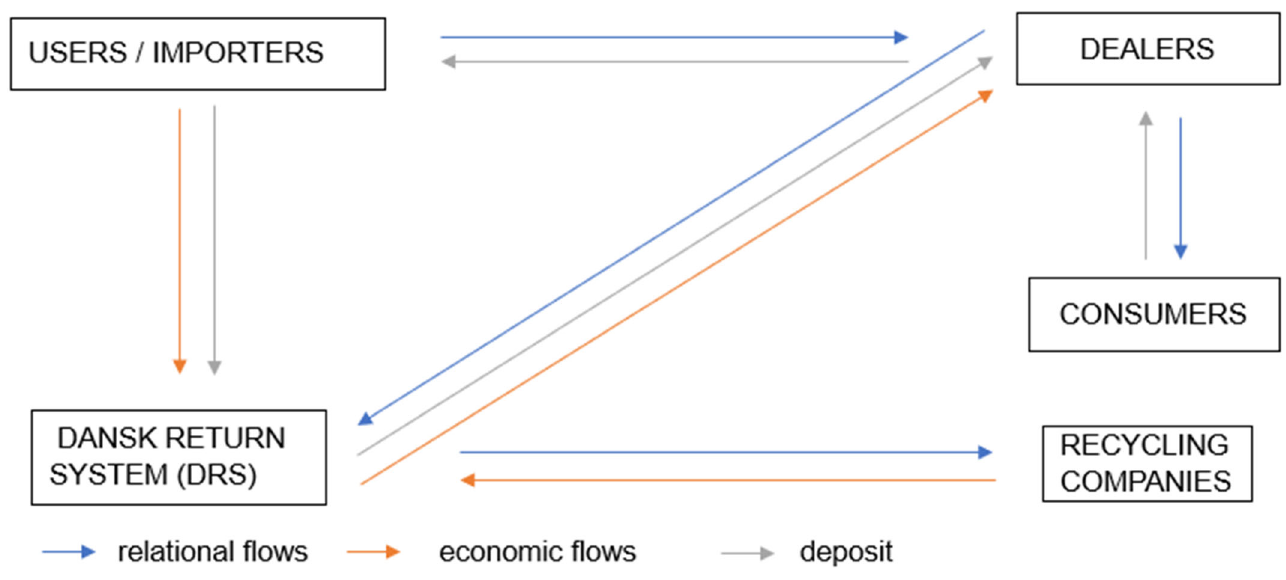
Figure 6. Danish model. Source: [31,36].